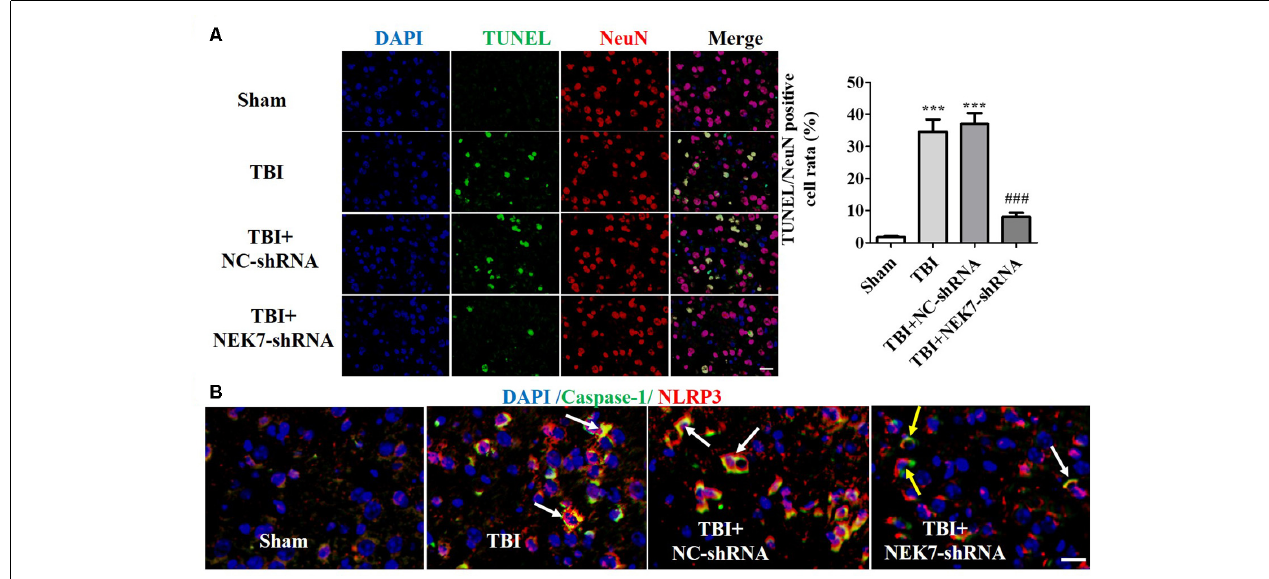
FIGURE 3 | NEK7 down-regulation further reduces cortical neuronal damage. (A) Cortical injuries to coronal sections were conducted using TUNEL staining 48 h post-TBI. Nuclei were stained with DAPI and neurons were stained with NeuN. Arrows indicate significant neuronal damage. Histogram analysis of